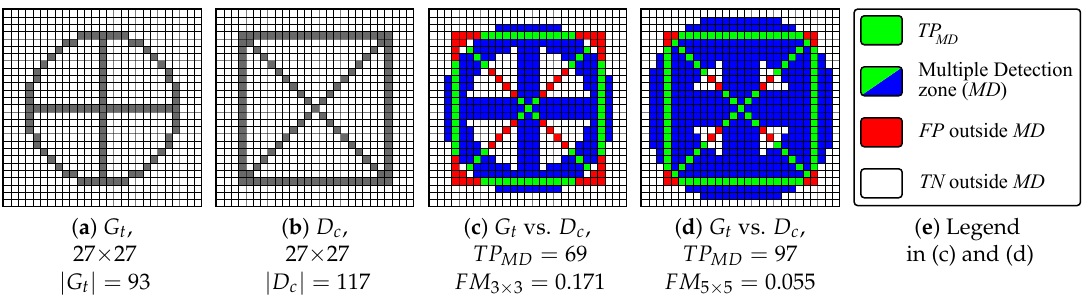
Figure 7. Failure Measure ( FM ) evaluation with two different Multiple Detection ( MD ) zones: in ( c ), dilation of G t with structuring element 3 × 3, and 5 × 5 in ( d ). The greater the MD area, the lower the FM error.